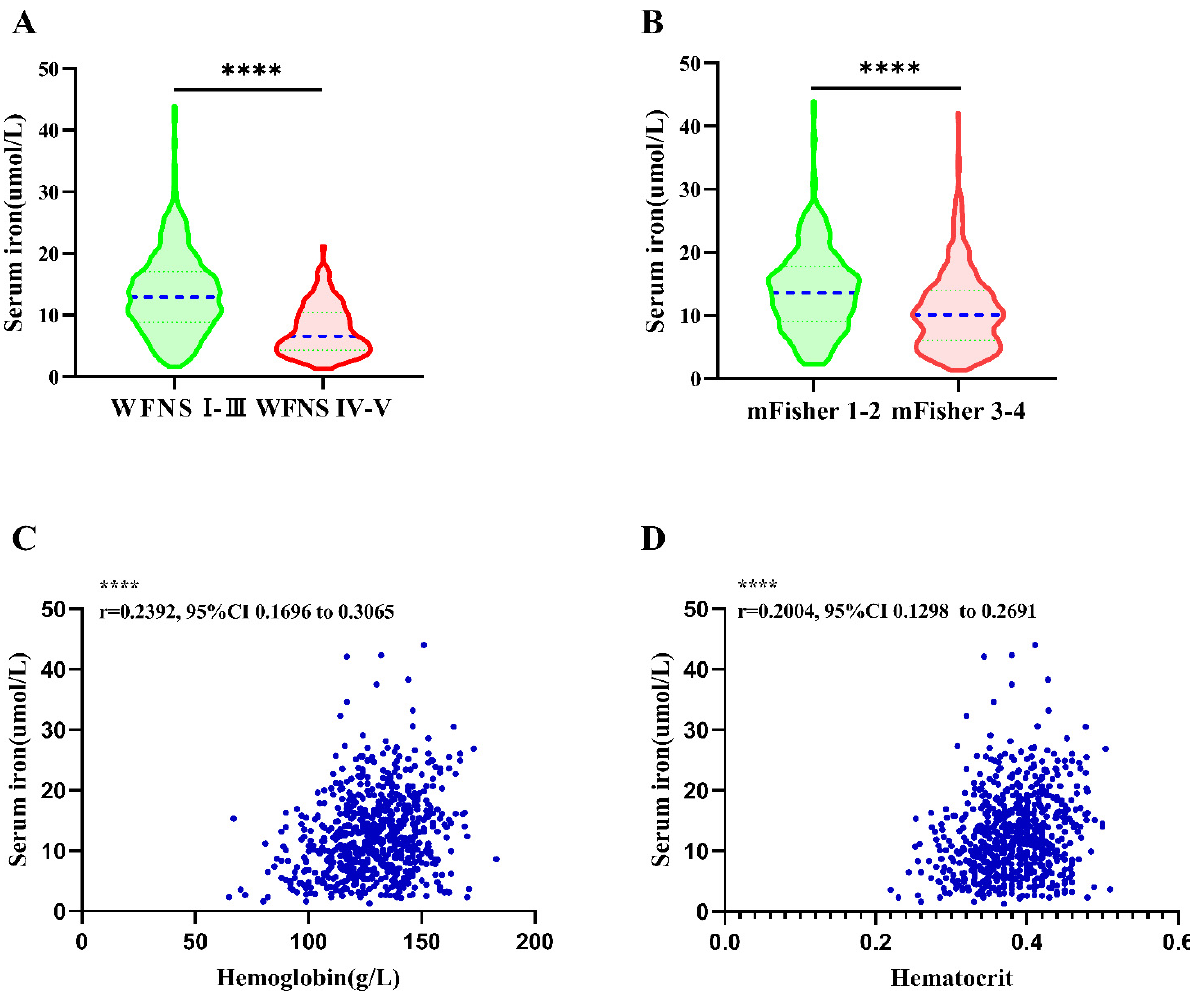
Figure 2. Associations between serum iron levels and initial clinical status. ( A ) Comparison of serum iron in aSAH patients between mild (WFNS grade I-III) clinical conditions and severe (WFNS grade IV–V) clinical conditions. ( B ) Serum iron levels in patients with mild (mFisher1–2) and severe (mFisher3–4) aSAH. ( C ) The correlation of serum iron levels with hemoglobin. ( D ) The correlation of serum iron levels with Hematocrit. Data were shown for violin plots in panel A and panel B. Groups were compared using Student’ t -test. Correlations were determined using Pearson’s correlation analysis. (****: p ≤ 0.0001) aSAH: aneurysmal subarachnoid hemorrhage; DCI: delayed cere- bral ischemia; WFNS: world federation of neurosurgical societies; mFisher: modified Fisher.